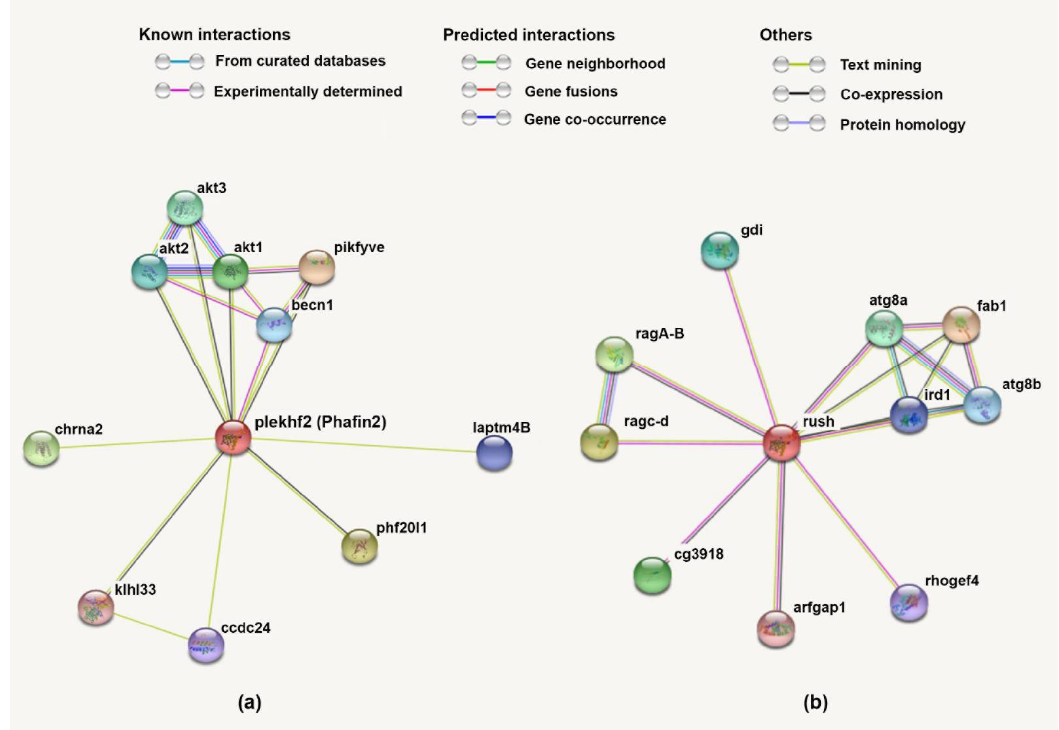
Figure 7. Protein–protein interaction network of human Phafin2 ( a ) and D. melanogaster Rush ( b ) generated using the STRING database. The color of the lines connecting the proteins indicates the typology of the protein–protein interaction. ( a ) BECN1, Beclin-1; PIKFYVE, PtdIns3P 5-kinase; PHF20L1, PHD finger protein 20-like protein 1; CHRNA2, neuronal acetylcholine receptor subunit α-2; LAPTM4B, lysosomal-associated transmembrane protein 4B; CCDC24, coiled-coil domain-containing protein 24; KLHL33, Kelch-like family member 33. ( b ) Atg8a, autophagy-related 8a; Atg8b, autophagy-related 8b; ird1, immune response-deficient 1; Gdi, guanine dissociation inhibitor; fab1, formation of aploid and binucleate cells 1; ArfGAP1, ADP-ribosylation factor GTPase-activating protein-1; Rho GEF4, Rho guanine exchange factor 4.